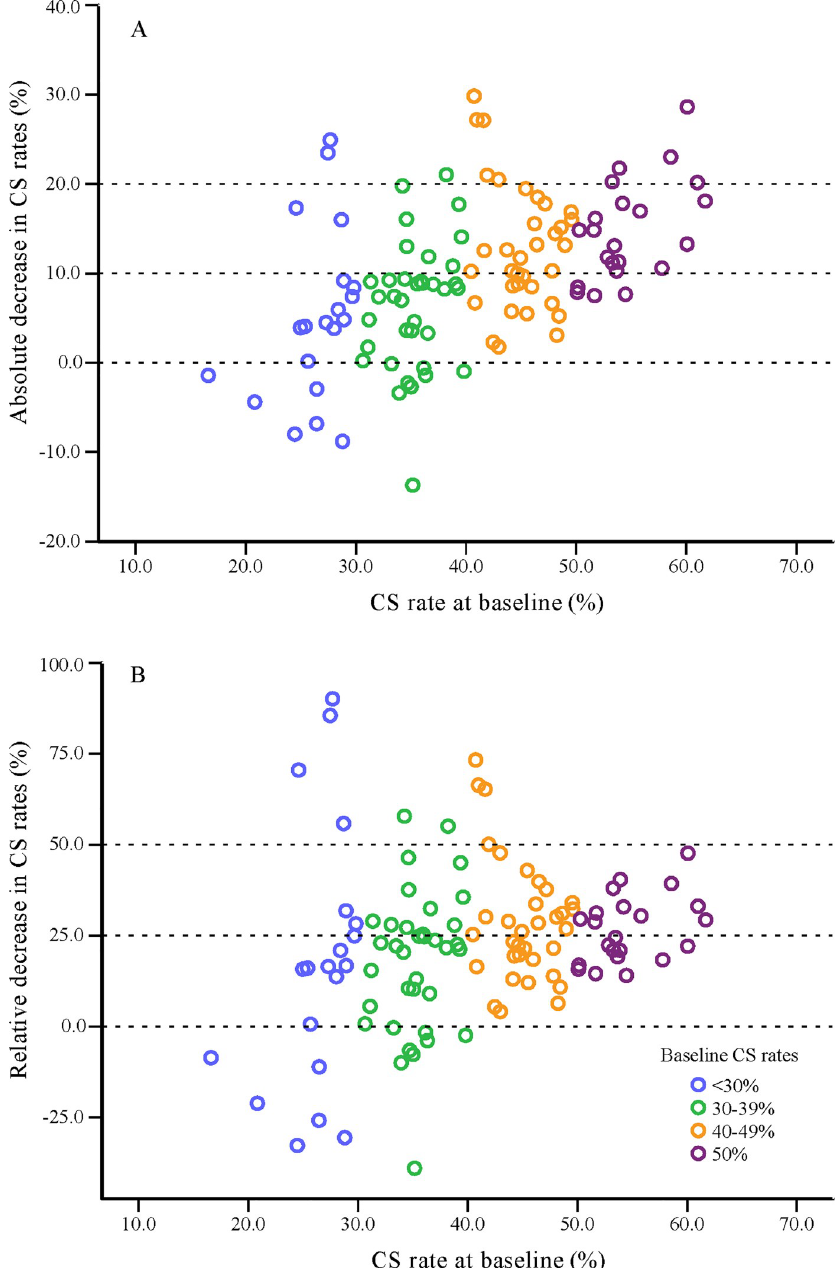
Fig 4. Scatter plot for the absolute decrease in CS rates (A) and the relative decrease in CS rates (B) from 2008 to 2016 among hospitals in Guangzhou grouped by their baseline CS rates. A total of 112 hospitals with more than 100 live births both at baseline and in Stage 2 were included and were grouped by their baseline CS rates. One circle represents one hospital, with blue ( n = 20), green ( n = 36), orange ( n = 34), and purple ( n = 22) representing baseline CS rates of < 30%, 30%–39%, 40%–49%, and � 50%, respectively. The absolute decrease = the CS rate at baseline − the CS rate in Stage 2; the relative decrease = (the CS rate at baseline − the CS rate in Stage 2) � the CS rate at baseline. CS, cesarean